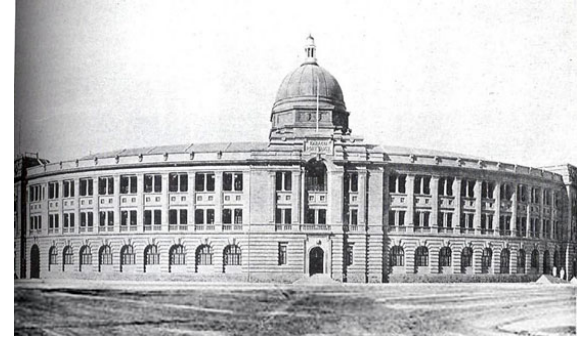
Figure 5. Karachi port trust KPT building.